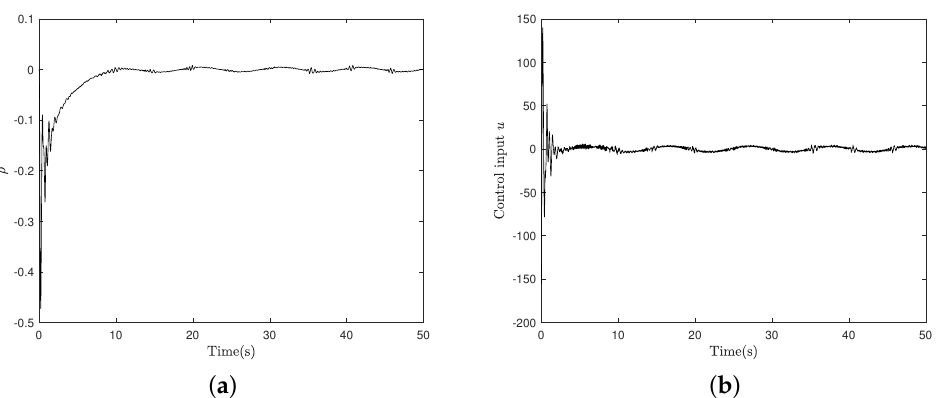
Figure 3. Input delay compensator and control input of the proposed control system for Example 1: ( a ) ρ ; and ( b ) u .